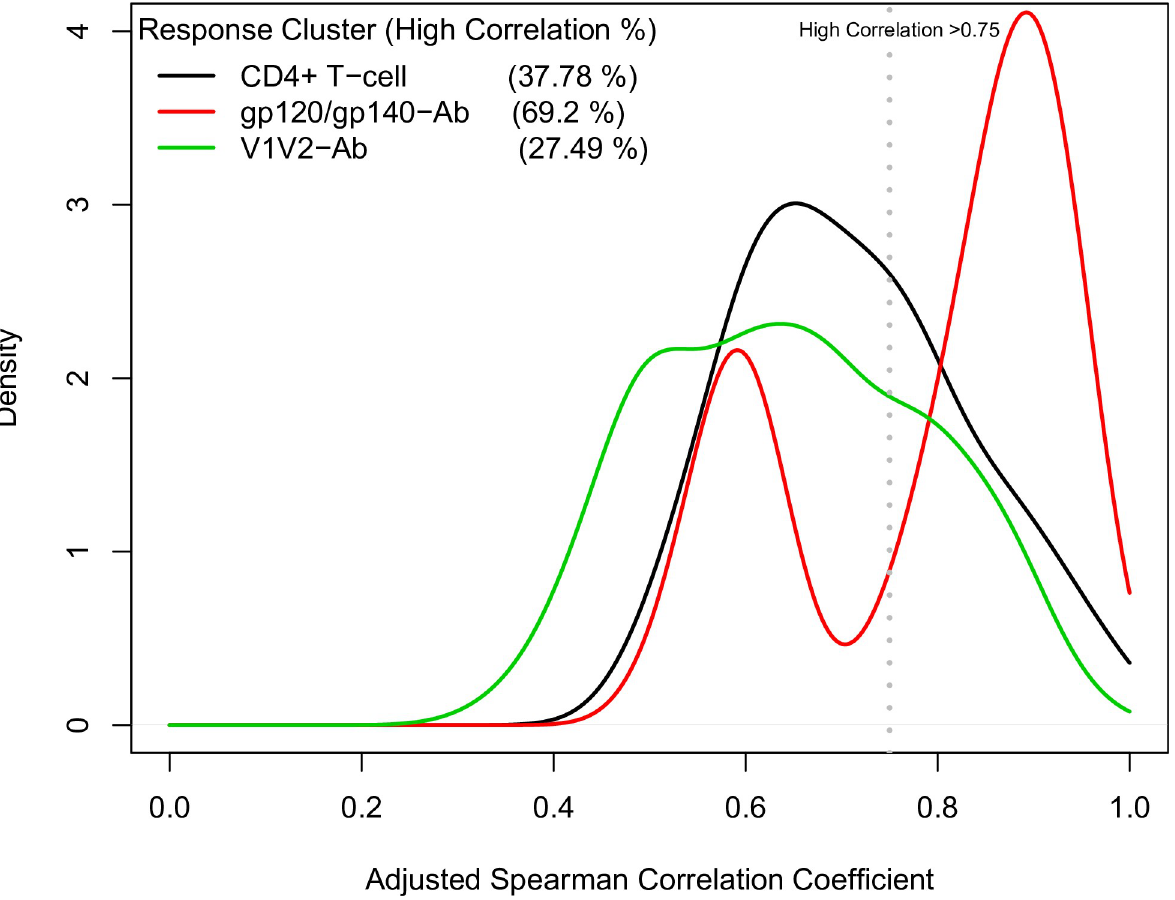
Fig 7. Distributions of study-adjusted rank-based Spearman correlations between immune variables within each of the three immune response clusters. Correlations were computed across participants in all three studies. The density (y-axis) indicates the relative number of immune response variable pairs with a given correlation (x-axis). “High correlation” was defined as a correlation greater than the threshold value of 0.75 (dashed